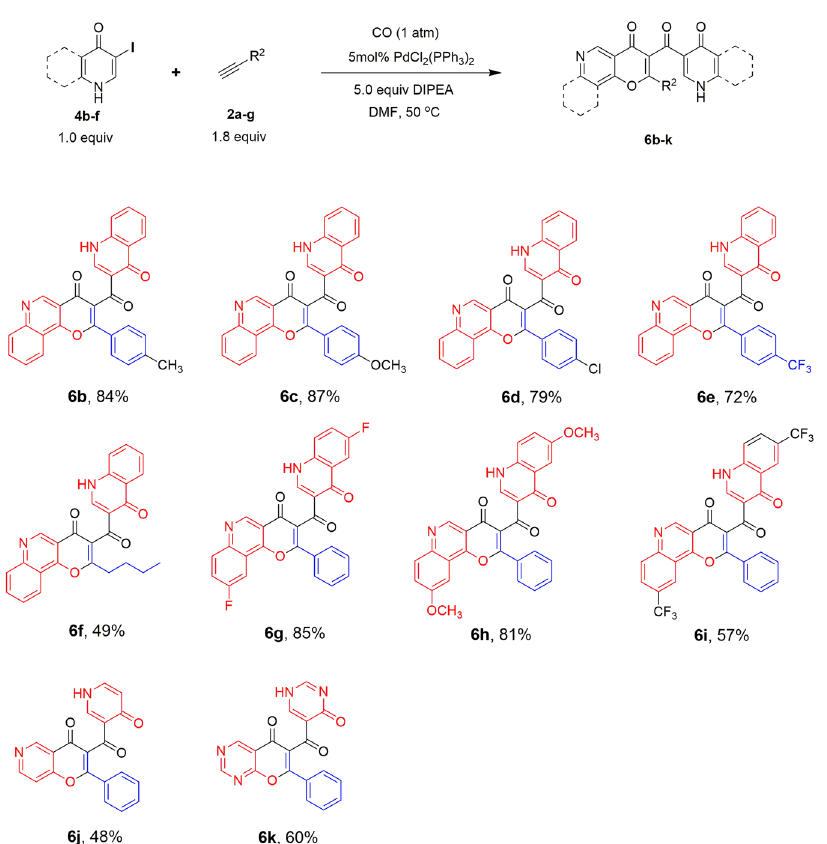
Figure 6. Synthesis of compounds 6b–k . a Reaction conditions: 4 (0.2 mmol), 2 (1.8 equiv), PdCl 2 (PPh 3 ) 2 (5 mol %), 5.0 equiv DIPEA, DMF (1 mL), CO (1 atm), stirred at 50 °C. b Isolated